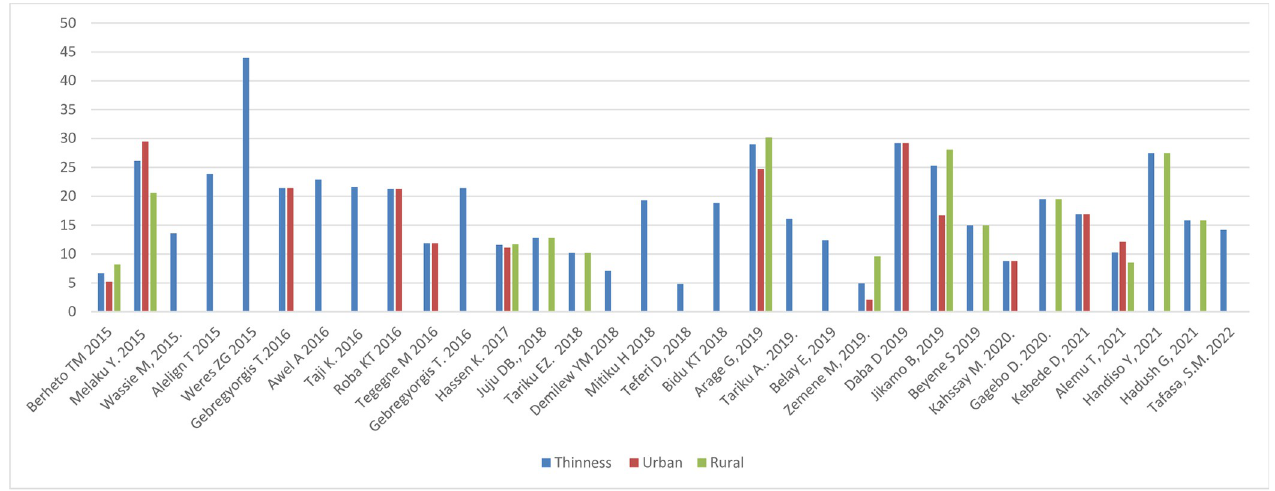
Fig 10. Trends in adolescent thinness by setting in Ethiopia over the last 6 years.